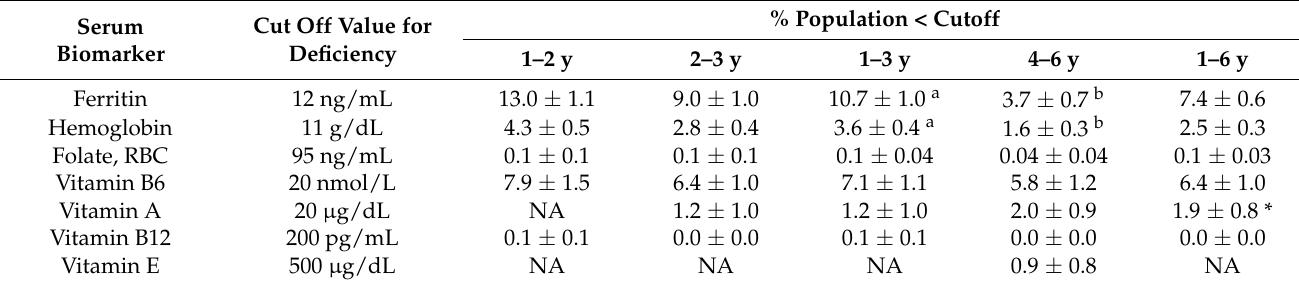
ab Percentages with different superscripts are significantly different (only the non-overlapping age groups 1–3 and 4–6 y were compared), p < 0.05. * Age group is 2–6 y (data not available for those 1 year of age). NA: Not